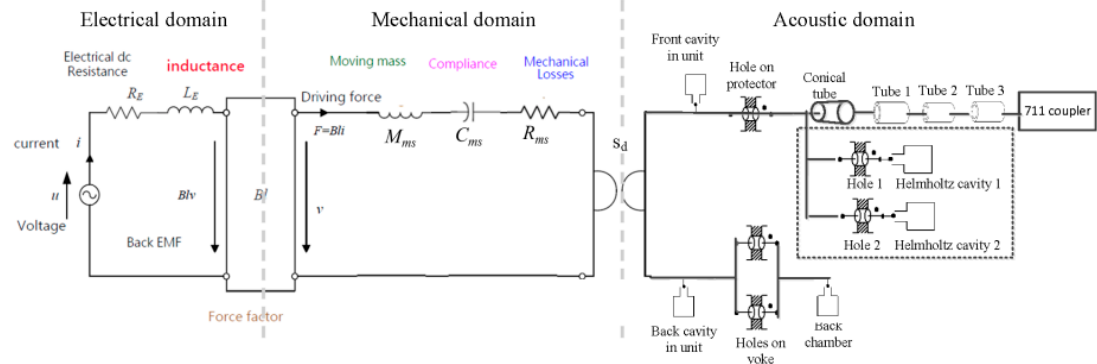
Figure 20. Equivalent circuit of earphone (with Helmholtz protector). Appl. Sci. 2019 , 9 , x FOR PEER REVIEW